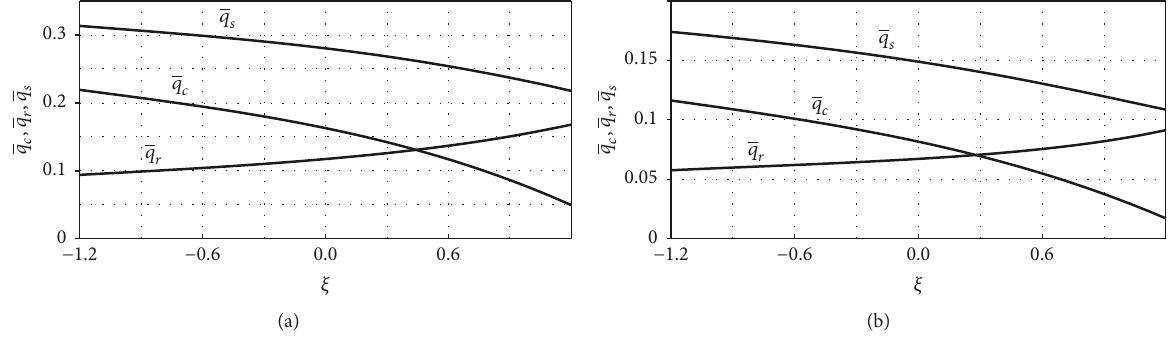
Figure 3: Dependencies of dimensionless conductive 𝑞 𝑟 , radiative 𝑞 𝑟 , and total 𝑞 energy fluxes on coordinate 𝜉 for two different values of hemispherical emissivity 𝜀 1 : ( 1 ) – 𝜀 1 = 0.2 ; (b) – 𝜀 1 = 0.5